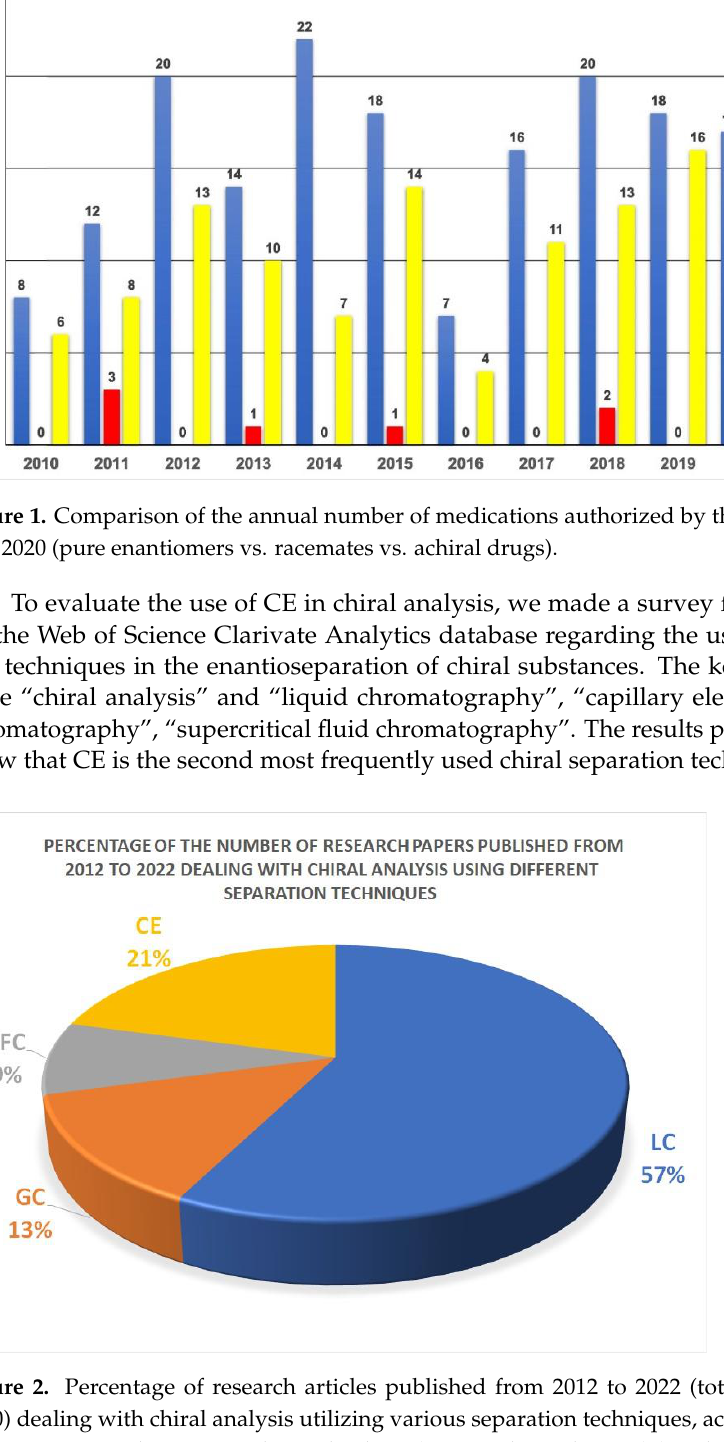
Figure 1. Comparison of the annual number of medications authorized by the FDA between 2010 and 2020 (pure enantiomers vs. racemates vs. achiral drugs).